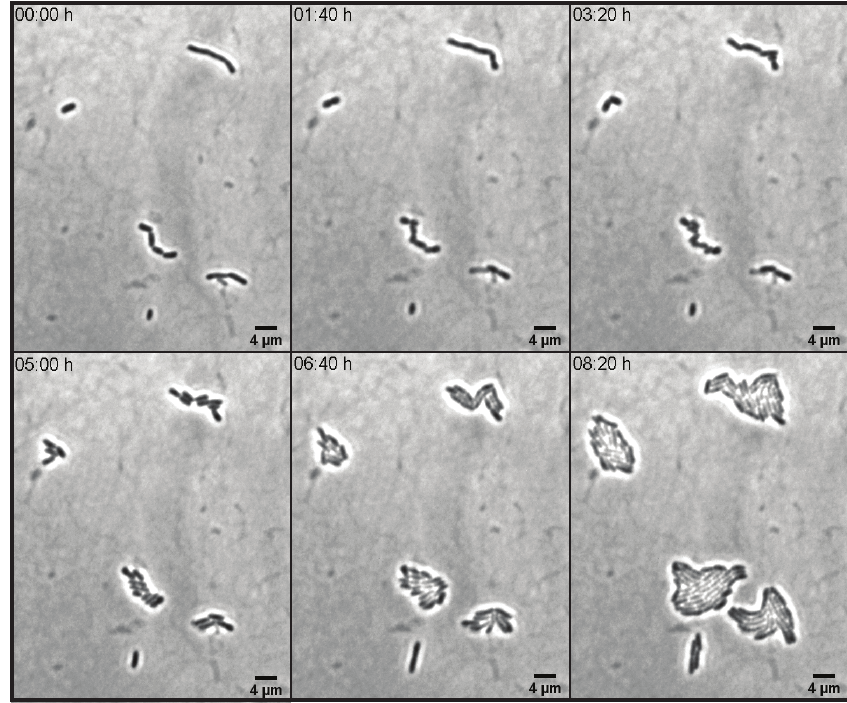
Figure 7. Time-lapse images of cells obtained at 0.8 m Na 2 SO 4 and subsequently grown on a thin LB-agar chamber without sodium